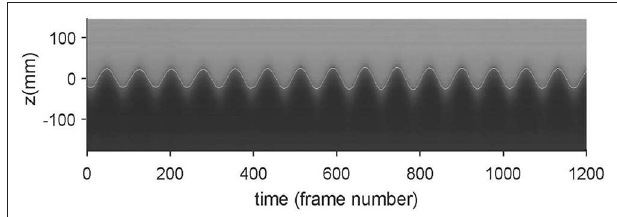
FIGURE 4 | Time stack image at an antinode with the digitally-identified interface location (white line)